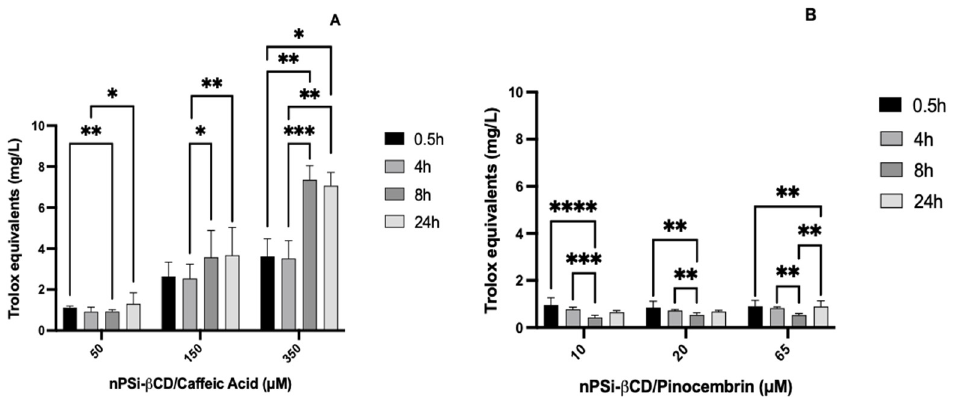
Figure 8. Kinetics of the antioxidant capacity of caffeic acid ( A ) and pinocembrin ( B ) loaded in the nPSi- β CD composite microparticle, expressed in Trolox equivalents (mg/L). The number of asterisks reflects the differences between the concentrations of the microencapsulated polyphenols tested. (* = p < 0.05; ** = p < 0.01; *** = p < 0.001; **** = p < 0.0001; n = 5).